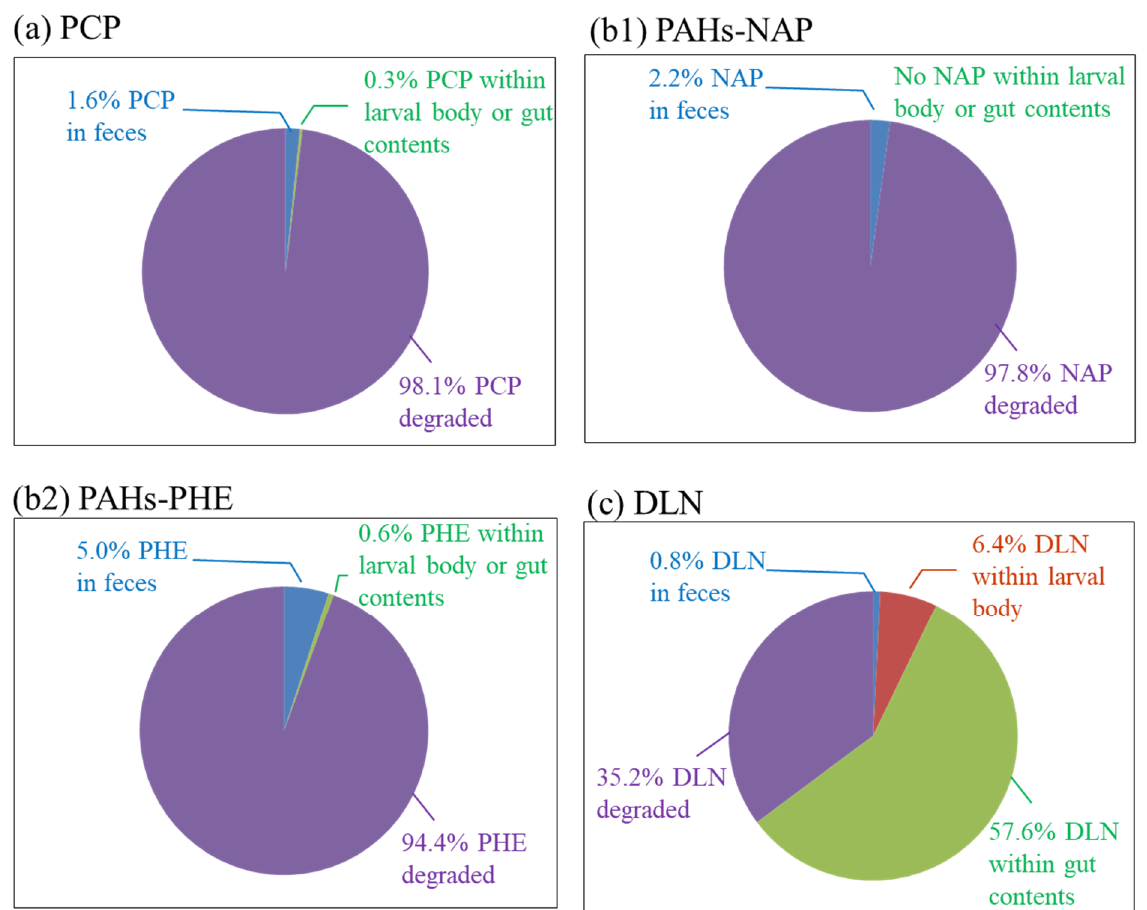
Figure 8. Mass flow of the tested PCP, PAHs and DLN, as labeled in ( a )–( c ), respectively, at the end of week 4.